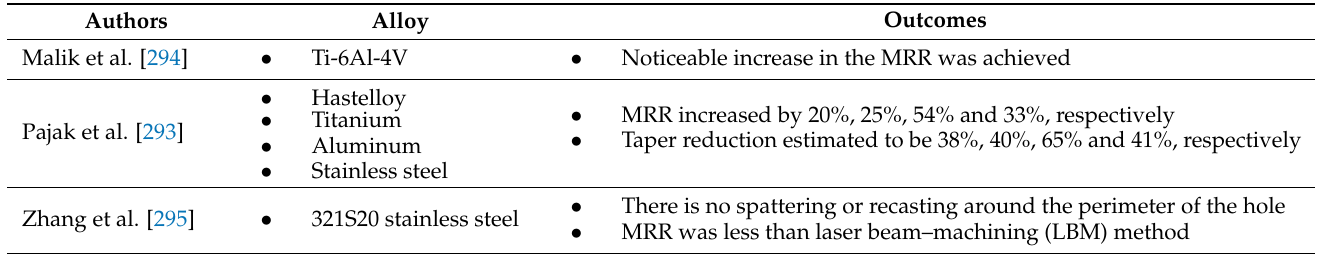
Table 24 represents the research conducted by using LA-JECM on biomedical alloys. Table 24. LA-JECM method on several biomedical